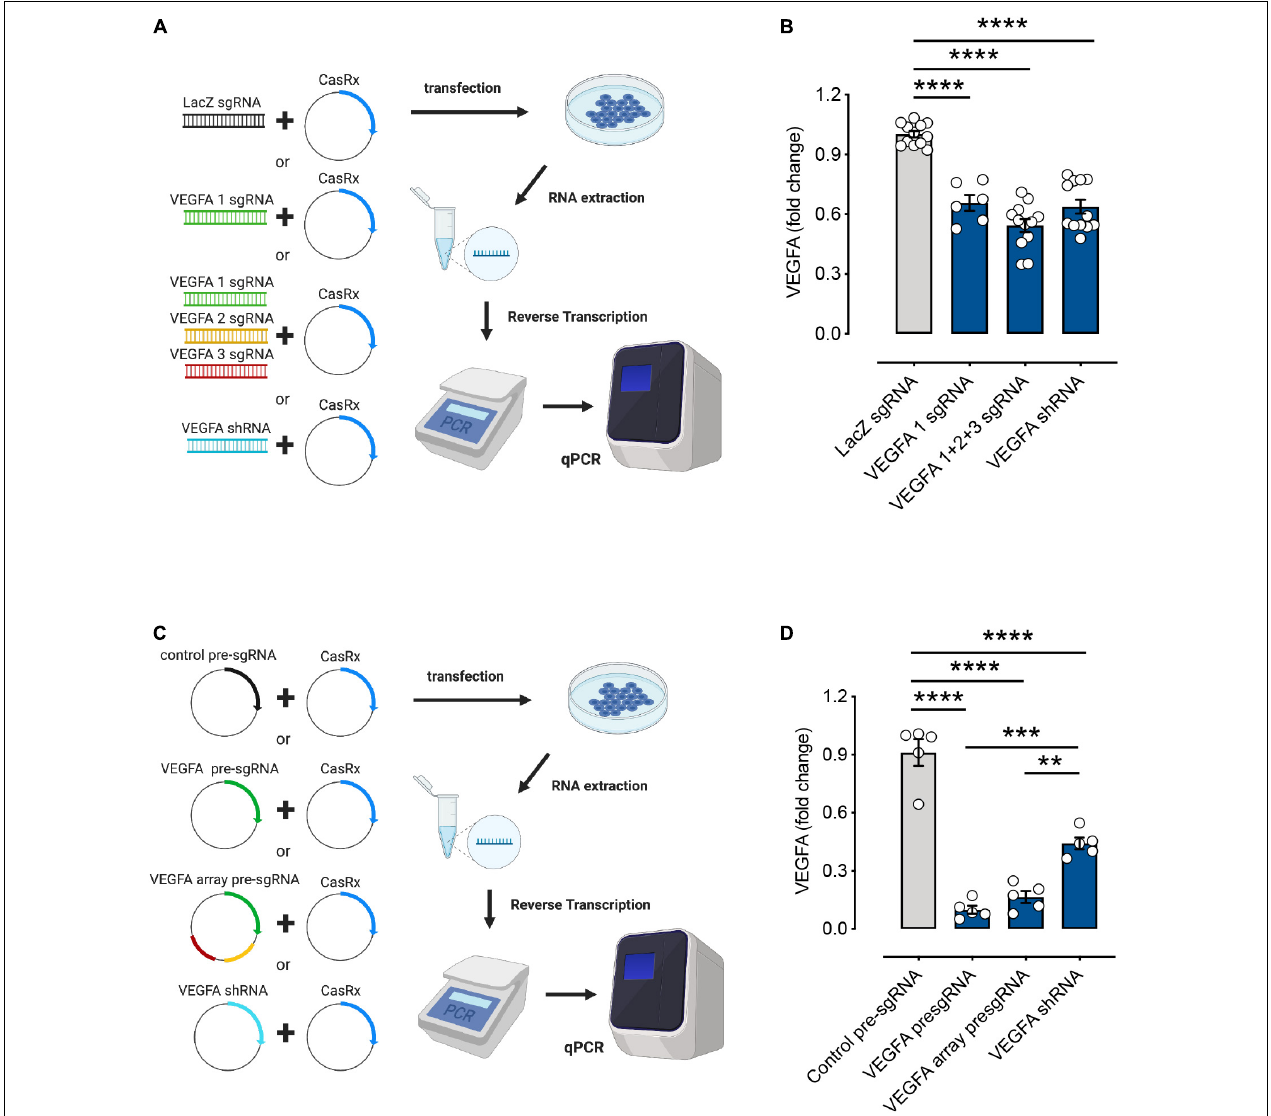
FIGURE 2 | RNA editing efficiencies of the CasRx system using different forms of single guide RNAs (sgRNA). (A) HEK293FT cells were transfected with the CasRx plasmid and short fragments of LacZ sgRNA (control), single vascular endothelial growth factor A (VEGFA) sgRNA, mixture of VEGFA sgRNAs (array), or VEGFA short hairpin (shRNA) for 72 h. (B) The VEGFA mRNA levels were determined by quantitative PCR (qPCR) as described in section “METHODS” ( n = 6–12). (C) HEK293FT cells were transfected with the CasRx plasmid and non-targeting (control) pre-sgRNA, VEGFA pre-sgRNA, VEGFA array pre-sgRNA, and VEGFA shRNA for 72 h. (D) The VEGFA mRNA level was determined by qPCR as described in section “METHODS” ( n = 5). Data are expressed as the mean ± SEM. Statistical analysis was performed with GraphPad Prism 7 (GraphPad, San Diego, CA, United States) and undertaken with one-way ANOVA and Tukey’s multiple comparison test. ** P < 0.01, *** P < 0.001, **** P < 0.0001. Created with BioRender.com.